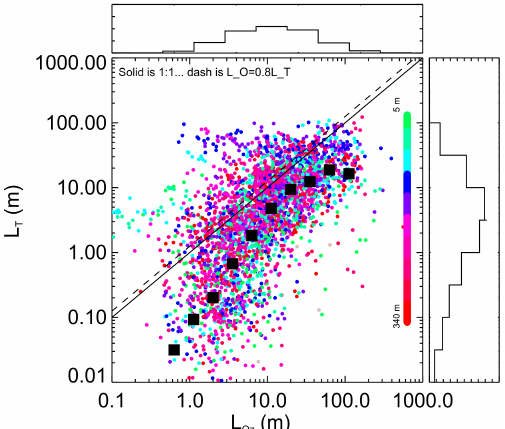
Figure 11. Scatter plot of L T vs. L Oz colour-coded by depth. Lines for unity and for L Oz = 0 . 8 L T are shown and associated histograms of length scales are shown also. Averages were calculated in log 10 space and 0.5m was considered a lower bound for L Oz .